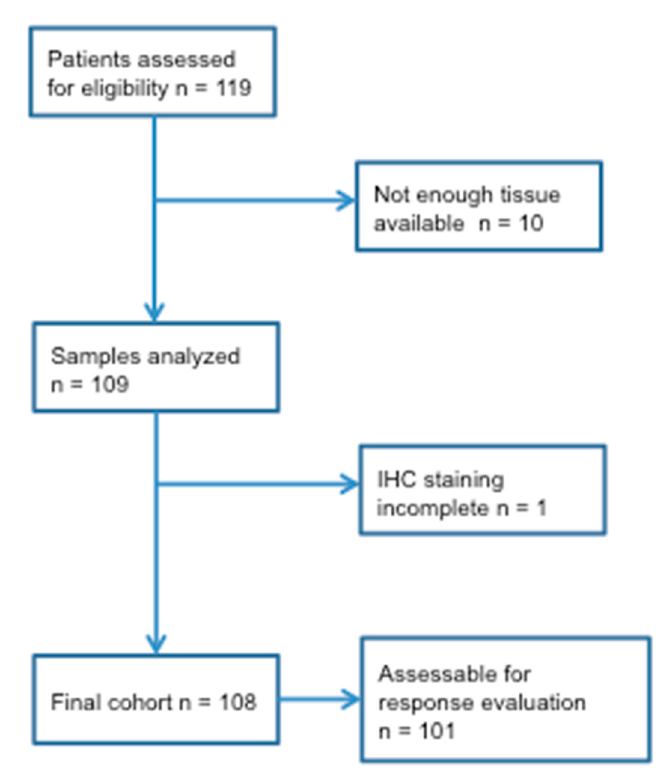
Figure 1. CONSORT diagram showing the flow of patients and samples. Table 1. Patient characteristics.